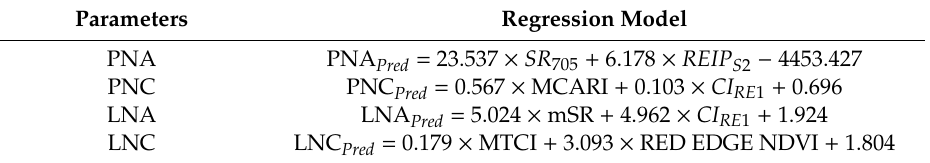
Table 7. Multiple regression models for different nitrogen nutrition parameters in the wheat anthesis